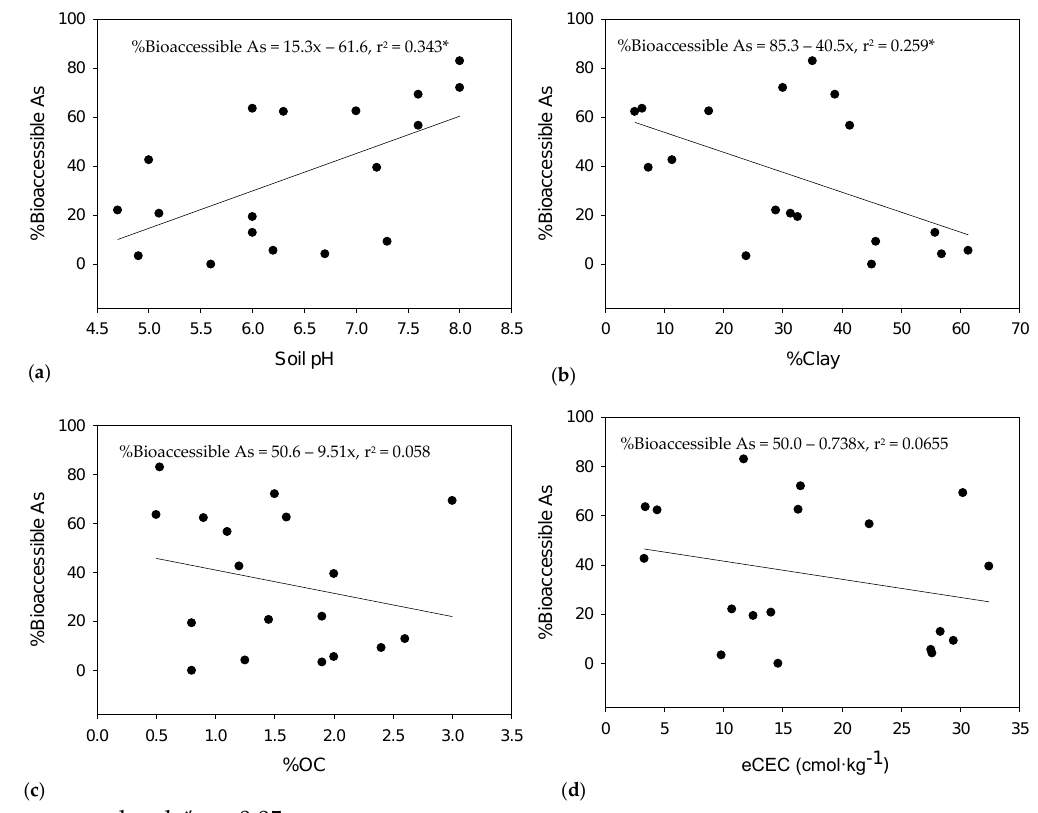
Figure 2. Effect of soil properties on %bio-accessible (IVBA) As. ( a ) Effect of soil spike pH on %bio-accessible As ( b ) Effect of soil %clay on %bio-accessible As ( c ) Effect of soil %OC on %bio-accessible As ( d ) Effect of soil effective CEC (cmol · kg − 1 ) on %bio-accessible As.